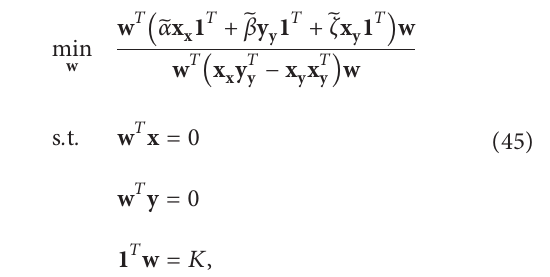
Table 1: Thinning virtual array without priori direction. Steps